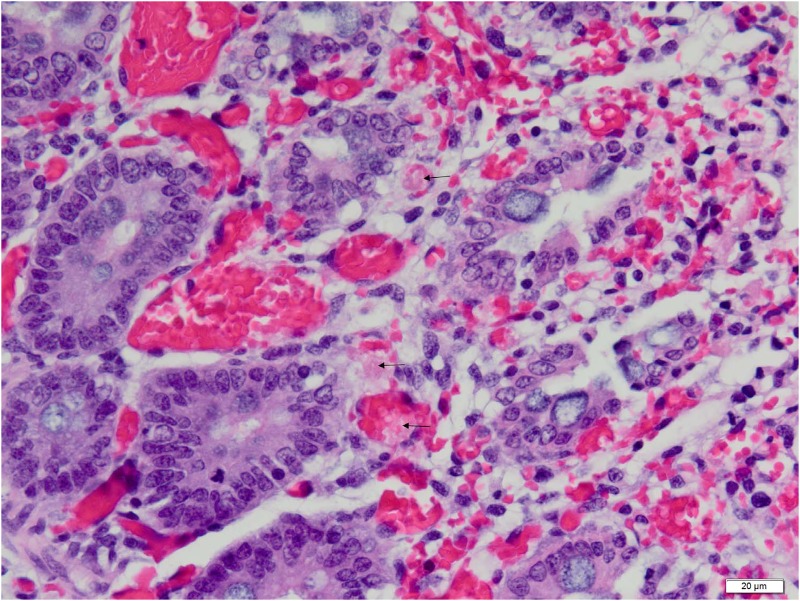
Higher (60X objective) magnification photomicrograph of the same field as that shown in Fig. 7.Eosinophilic platelet-fibrin thrombi (arrows) are seen in hyperemic capillaries and venules. Photomicrograph was taken of 4 μm-thick section of 10% neutral-buffered formalin-fixed, paraffin-embedded spiral colonic tissue stained with hematoxylin and eosin. Bar = 20 μm.